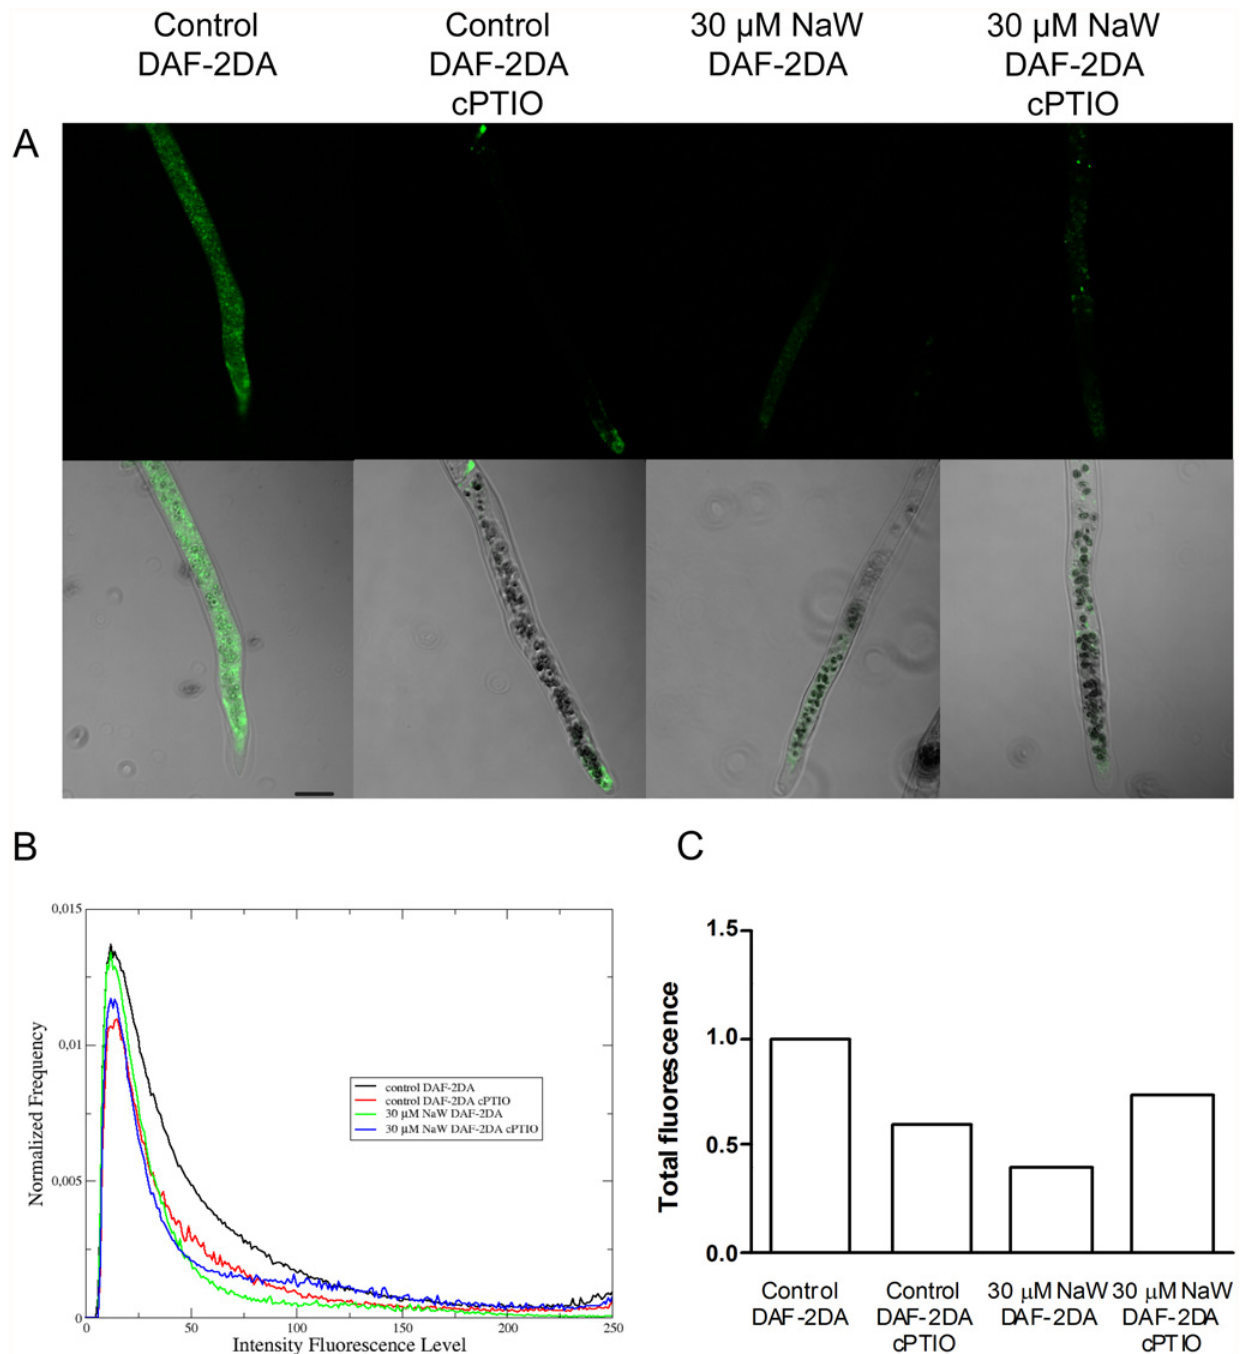
Fig 5. Nitric oxide detection in P. patens protonemal cells by confocal laser scanning microscopy. A) DAF-2DA green emission by protonemal cells grown for seven days on Knop medium or medium supplemented with 30 μ M sodium tungstate. Protonema was incubated in growth medium supplemented with 20 μ M DAF-2DA for 15 min. Some plants were preincubated with 200 μ M cPTIO for 45 minutes and then with DAF-2DA. Green signal indicates (cid:129) NO production. The micrographs show pairs of representative laser confocal microscopy and bright-field images of the protonemal cells. Scale bar = 50 μ m. B) Normalized average histograms, each curve describes the DAF-2DA green emission intensity distribution associated to a specific experimental treatment. C) For each treatment, the total DAF-2DA green emission intensity was obtained based on the area under the curves shown in B, and normalized according to DAF-2DA green signal intensity from untreated control. Data from two independent experiments (n = 22 – 28). The statistical independence between the distributions (B) was calculated using the Kolmogorov-Smirnov test.